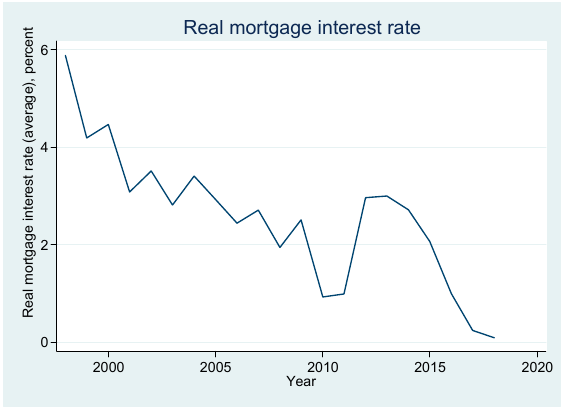
Source: Swedbank. Source: Swedbank. Source: Swedbank. Figure 9. Real mortgage interest rate in Sweden. Figure 9. Real mortgage interest rate in Sweden. Figure 9. Real mortgage interest rate in Sweden. Figure 9. Real mortgage interest rate in Sweden. The average real annual rent during the study period is SEK 968 per square meter The average real annual rent during the study period is SEK 968 per square meter The average real annual rent during the study period is SEK 968 per square meter The average real annual rent during the study period is SEK 968 per square meter with a standard deviation of SEK 121 per square meter (see Figure 10). The average real with a standard deviation of SEK 121 per square meter (see Figure 10). The average real with a standard deviation of SEK 121 per square meter (see Figure 10). The average real with a standard deviation of SEK 121 per square meter (see Figure 10). The average real price per square meter during the study period for housing cooperatives is SEK 25,498 per price per square meter during the study period for housing cooperatives is SEK 25,498 per price per square meter during the study period for housing cooperatives is SEK 25,498 per price per square meter during the study period for housing cooperatives is SEK 25,498 per square meter with standard deviation of SEK 16,300 per square meter (see Figure 11). square meter with standard deviation of SEK 16,300 per square meter (see Figure 11). square meter with standard deviation of SEK 16,300 per square meter (see Figure 11). square meter with standard deviation of SEK 16,300 per square meter (see Figure 11).